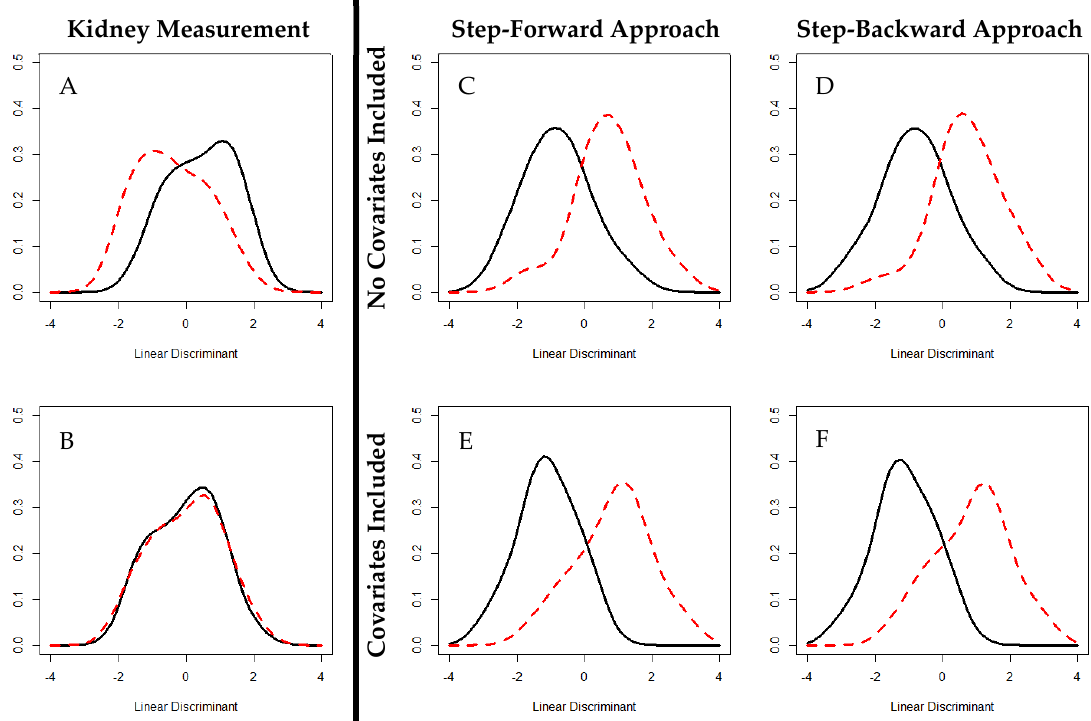
Figure 2. Linear discriminants of kidney measurements and DROP CKD models. Distinguishing Risk of Progressive CKD models, calculated via linear discriminant analysis, were more accurate than those calculated for the kidney measurements eGFR ( A ) and albuminuria ( B ) when predicting future progressive CKD at baseline in the Predictive Model cohort. eGFR and albuminuria conferred accuracies of 66.1 % and 53.2%, respectively. The step-forward ( C ) approach calculated a predictive model with an accuracy of 84.3% with the biomarkers sCr, eGFR, osteopontin, tryptase, and urea. When including basic covariates (age, body mass index, follow-up time, kidney disease diagnosis, and gender) the step-forward approach ( D ) had an accuracy of 83.3%. The step-backward approach ( E ) calculated a predictive model with an accuracy of 86.3% with the bicarbonate biomarkers, osteopontin, SCF, tissue factor, tryptase, urea, sCr, and eGFR. When including basic covariates, the step-backward approach ( F ) had an accuracy of 81.25% Frequency of linear discriminants was plotted by progressive (dashed, red) and non-progressive (solid, black) CKD. Greater separation of progressive and non-progressive distributions indicates greater accuracy when predicting progressive CKD by a predictive model. Abbreviations: Estimated glomerular filtration rate (eGFR), serum creatinine (sCR), stem cell factor (SCF).